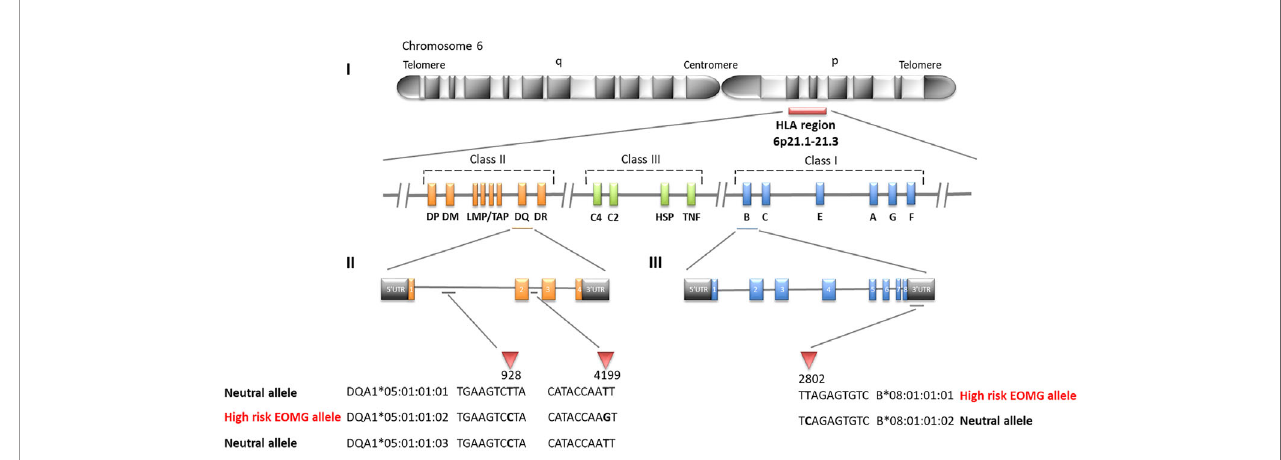
FIGURE 1 | SNP differences in HLA alleles strongly associated with early-onset myasthenia gravis (EOMG) (I) Simpli fi ed map of the HLA region (II) Three different 4- fi eld intronic variants of HLA-DQA1*05:01:01 , only HLA-DQA1*05:01:01:02 is associated with high risk of EOMG the other alleles have neutral effects (III) Two 4- fi eld variants of HLA-B*08:01:01 are distinguished by a SNP located in the 3 ’ UTR; HLA-B*08:01:01:01 is a high risk EOMG allele whereas HLA-B*08:01:01:02 is